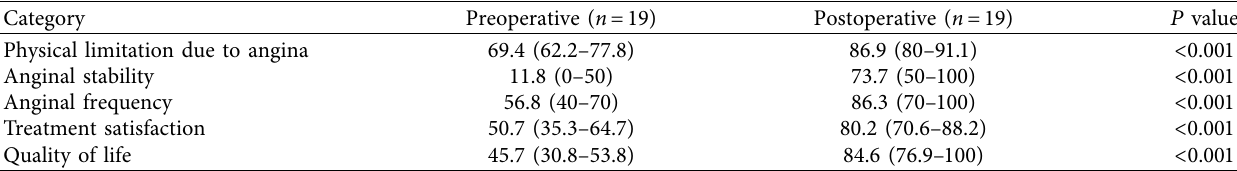
Table 4: Seattle angina questionnaire scores before and after unroofng in the blunt dissection group.